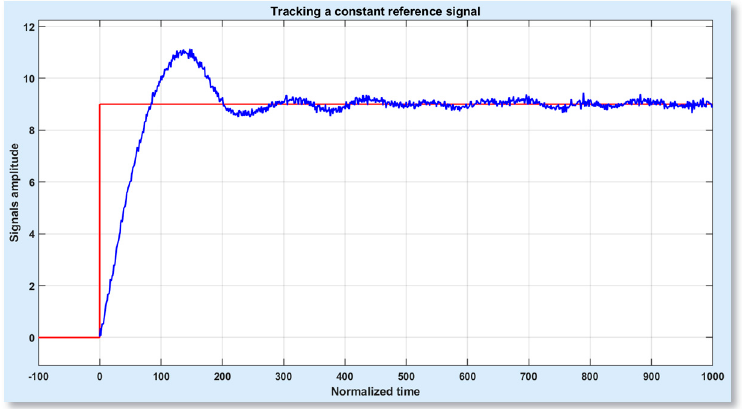
Figure 5. Example of noisy output signal tracking the prescribed